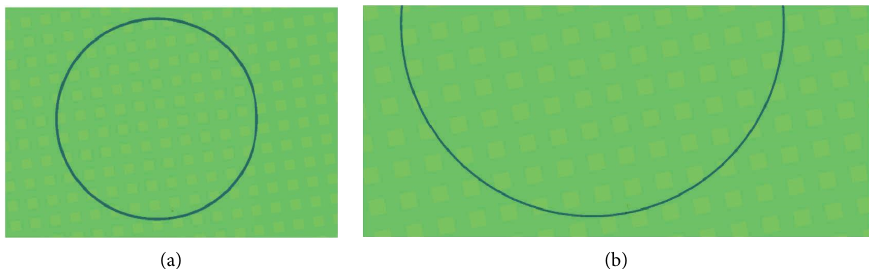
Figure 3: Generation of fxed shapes after code modifcation. (a) Fixed curvature of 500m. (b) Fixed curvature of 1700m.